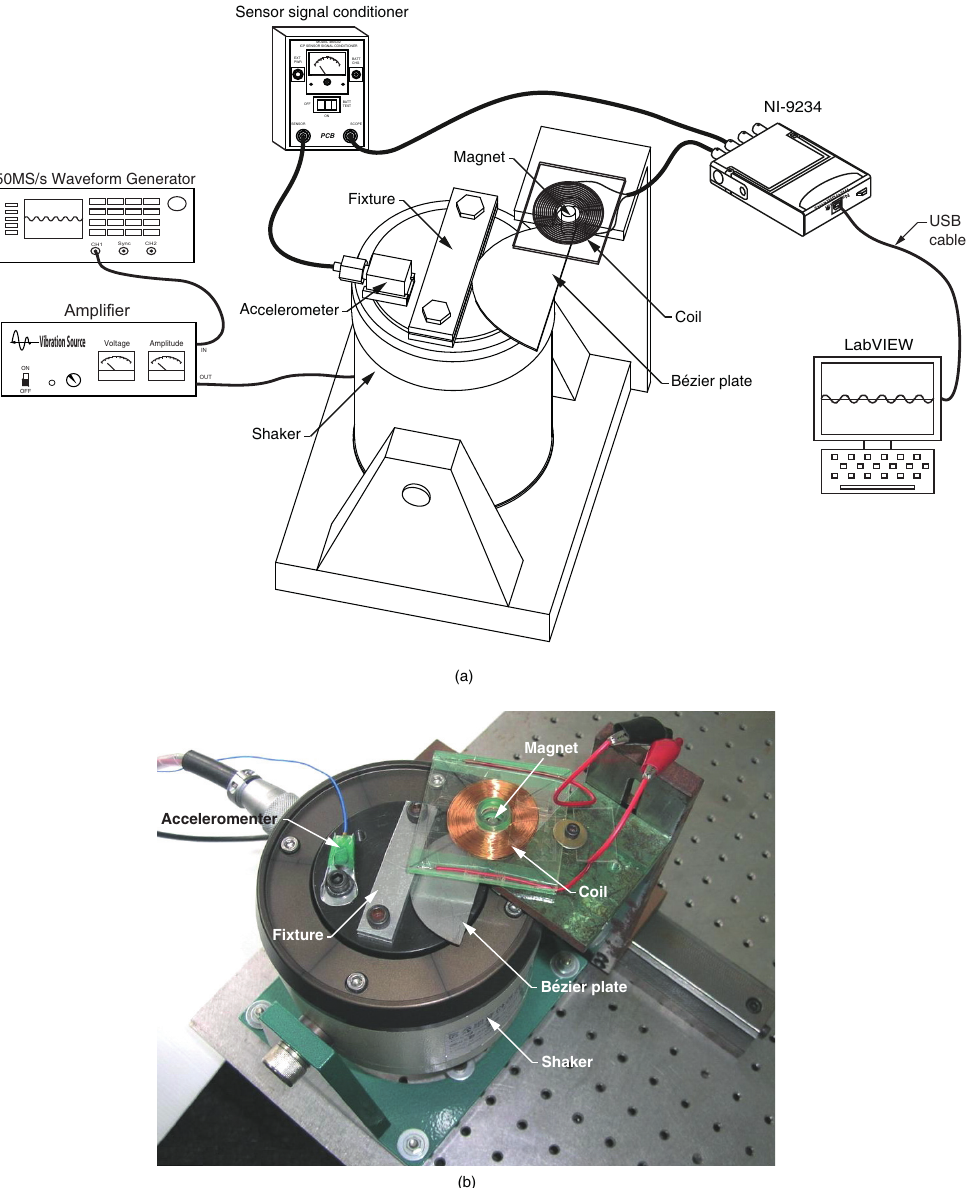
Figure 10. ( a ) Schematic; ( b ) photo of the experimental setup.